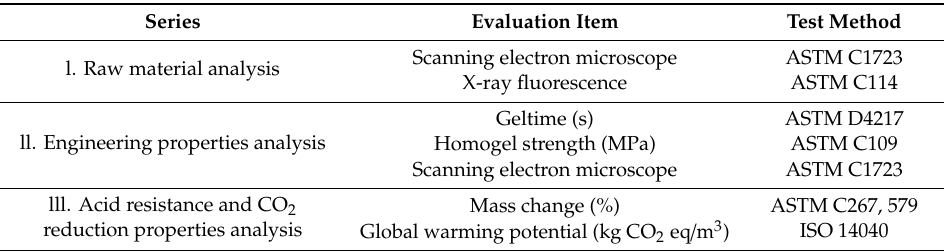
Table 5. Test methods by evaluation